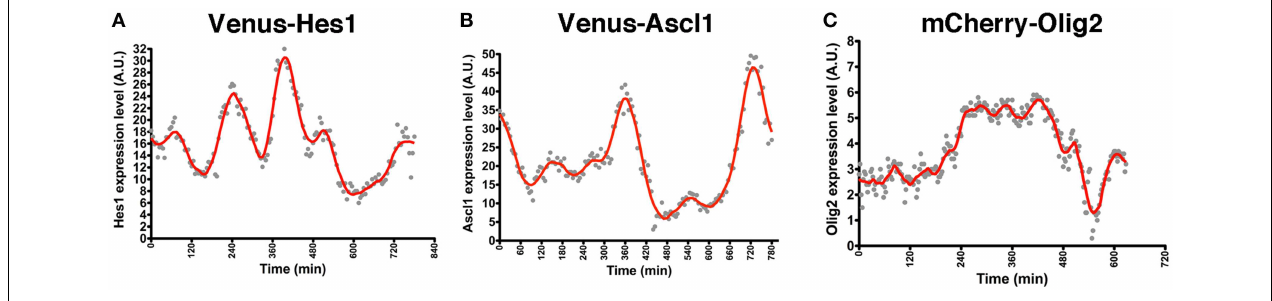
quantification of each fusion protein dynamics in self-renewing NSCs. The graphs of this figure are reprinted from Supplementary Figures S8C; S11G; S12D of Imayoshi et al. (2013b).